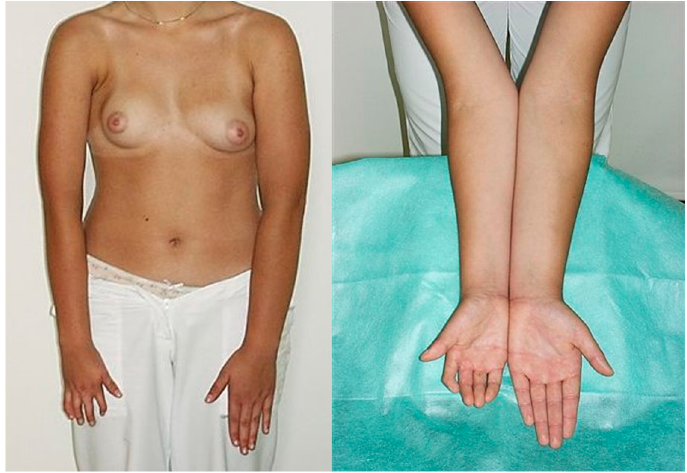
Figure 1. 25-year-old female patient with right-sided Poland syndrome (frontal view of the chest after right breast reconstruction with silicone implant and hand appearance).